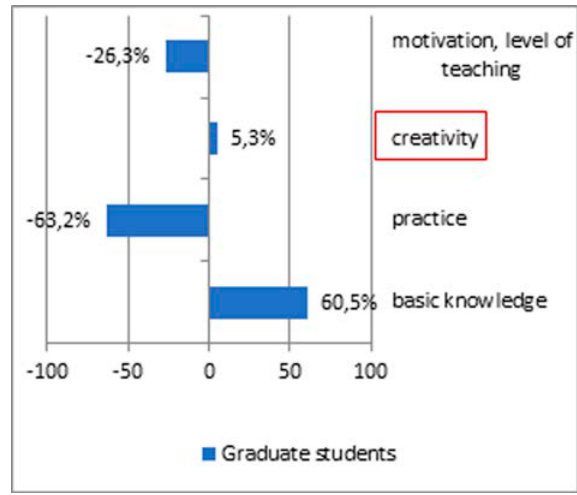
Fig. 6. Subjective opinions of graduate students about the level of training of a graduate of MSTU Stankin.